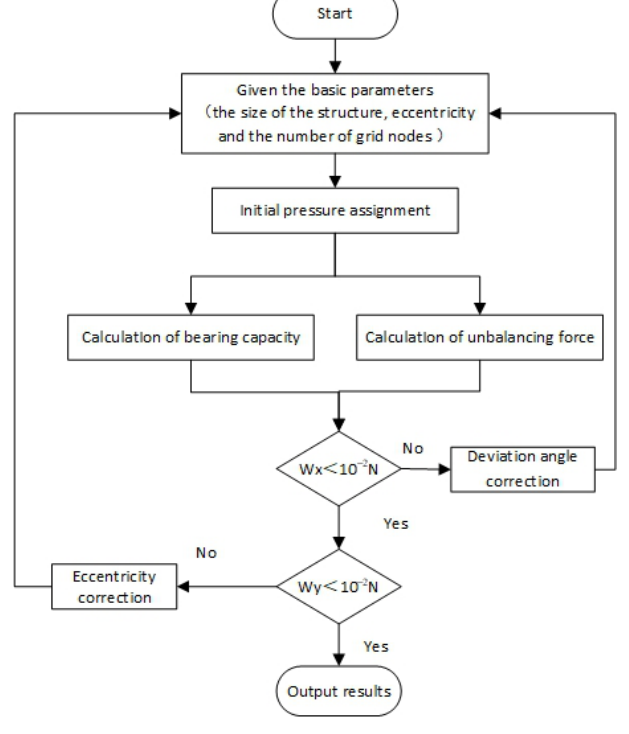
Figure 4. Calculation flow chart.